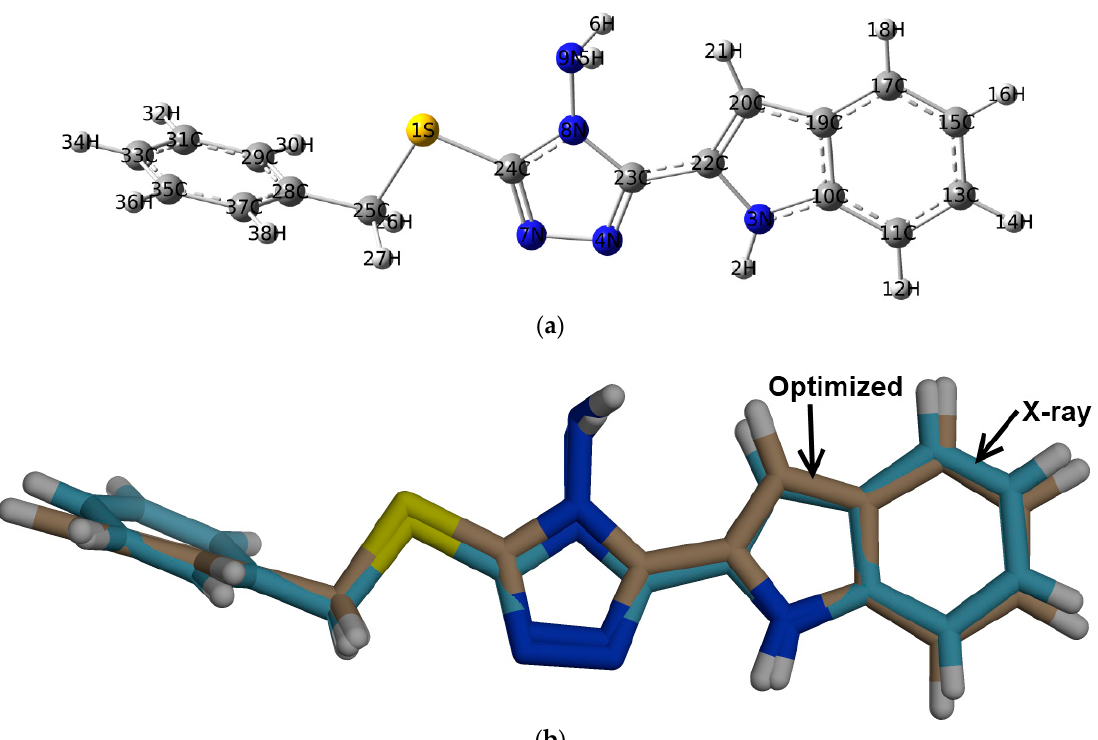
Figure 6. The optimized geometry ( a ) and overlay of the optimized ( beige ) with experimental ( blue ) structures, ( b ) for 2 .